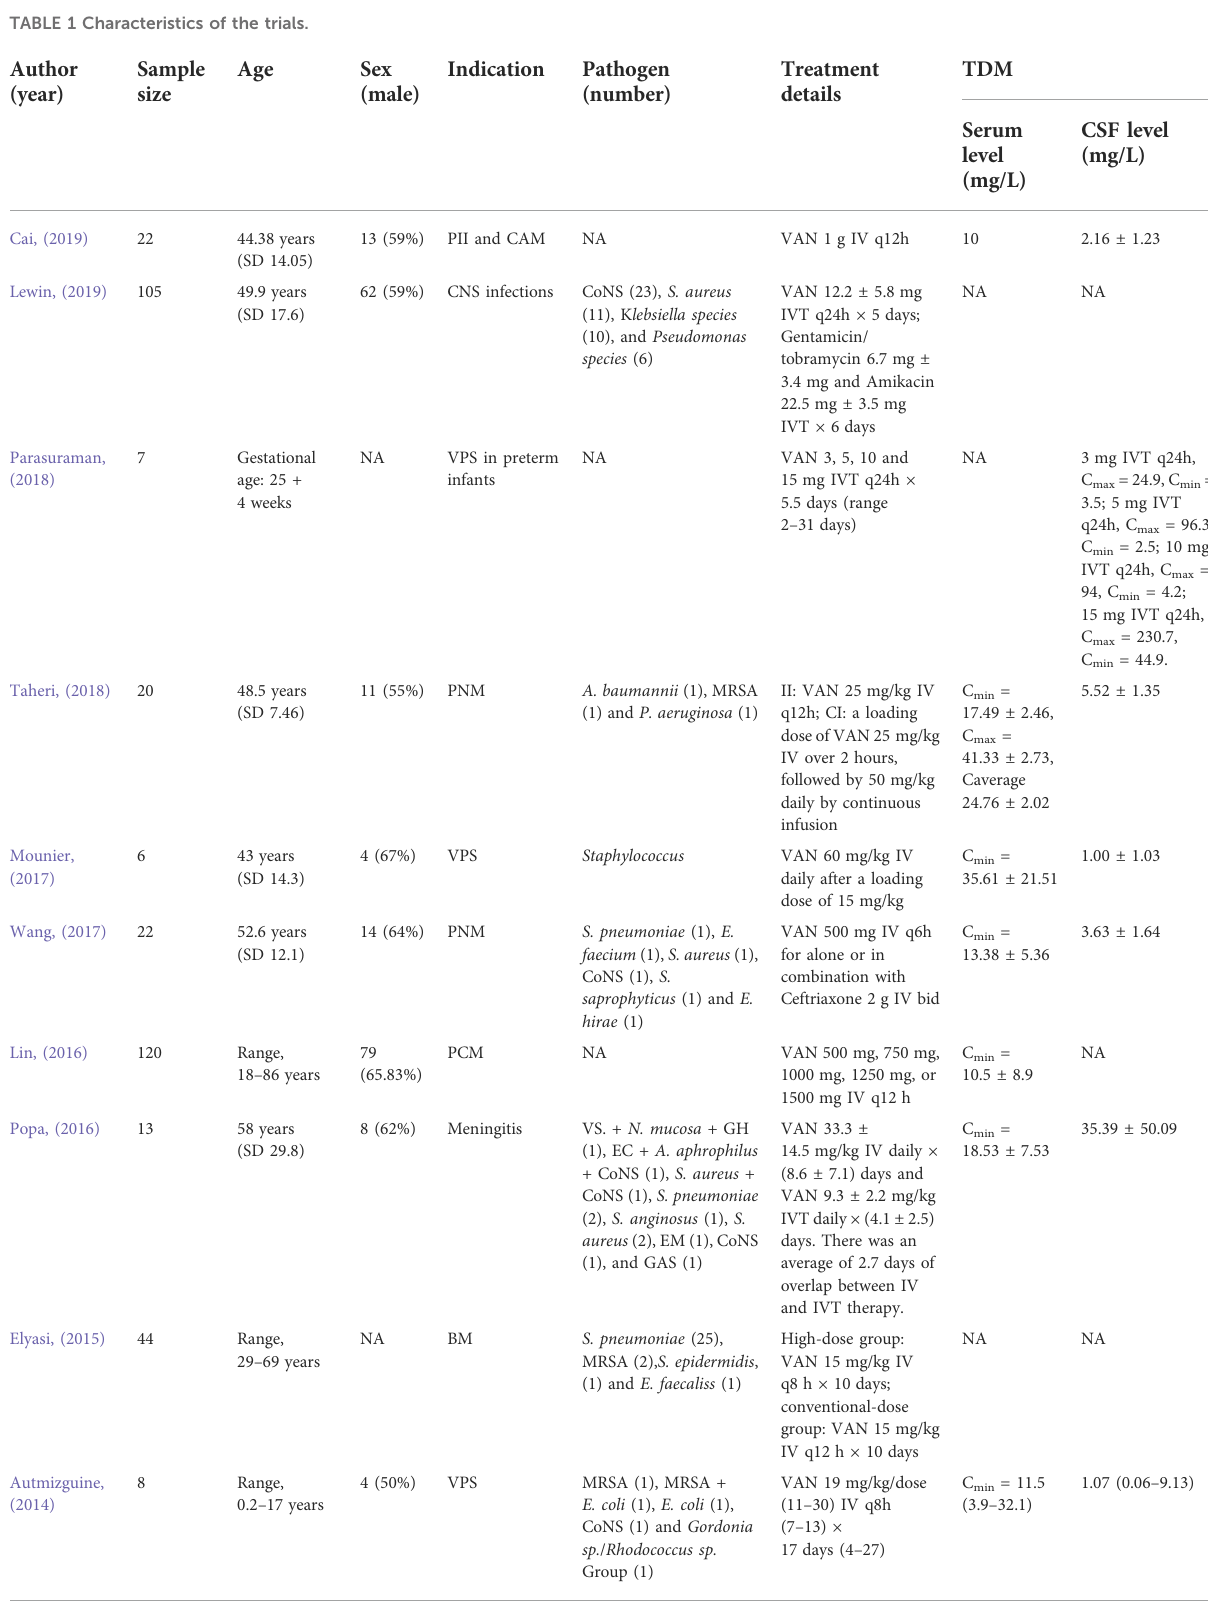
TABLE 1 Characteristics of the